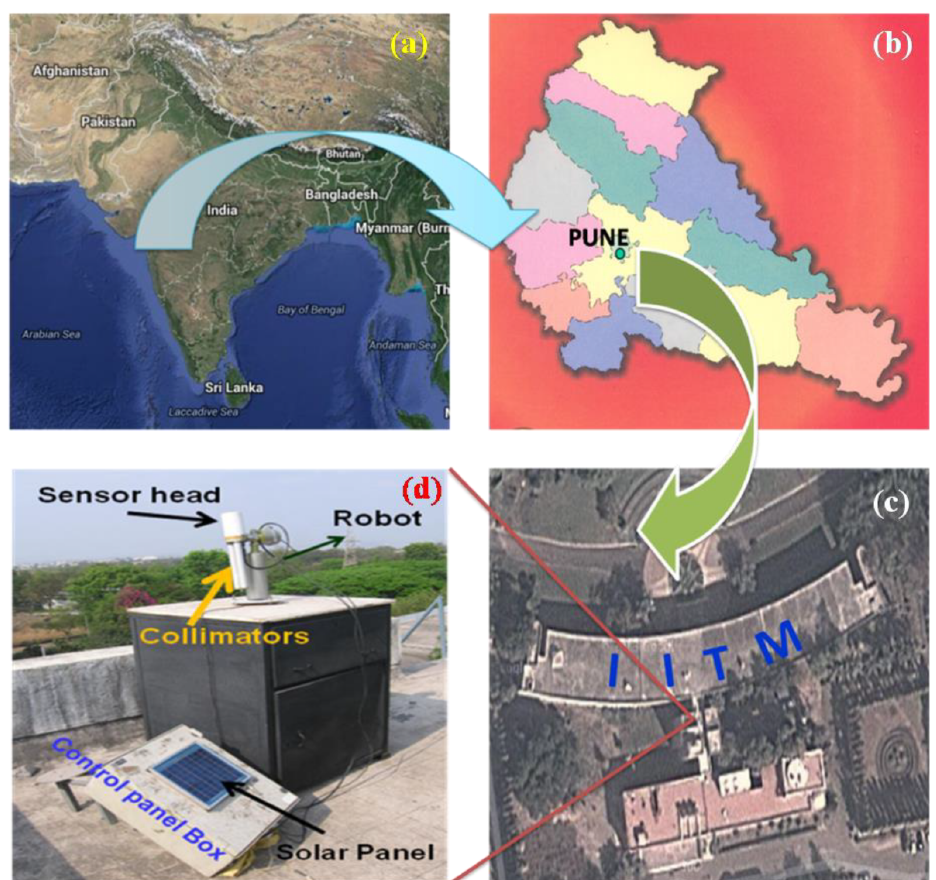
Figure 1. Location of Cimel Sun–sky radiometer and its surroundings at the Indian Institute of Tropical Meteorology (IITM), Pune (18 ◦ 32 (cid:48) N, 73 ◦ 51 (cid:48) E; 559ma.m.s.l.), Maharashtra State, India: (a, c) base map from © Google Earth, source: https://www.google.com/earth/, last access: 19 September 2020; (b) base map from © Google images of Maharashtra state map; (d) radiometer with mount and control panel box with solar panel at the